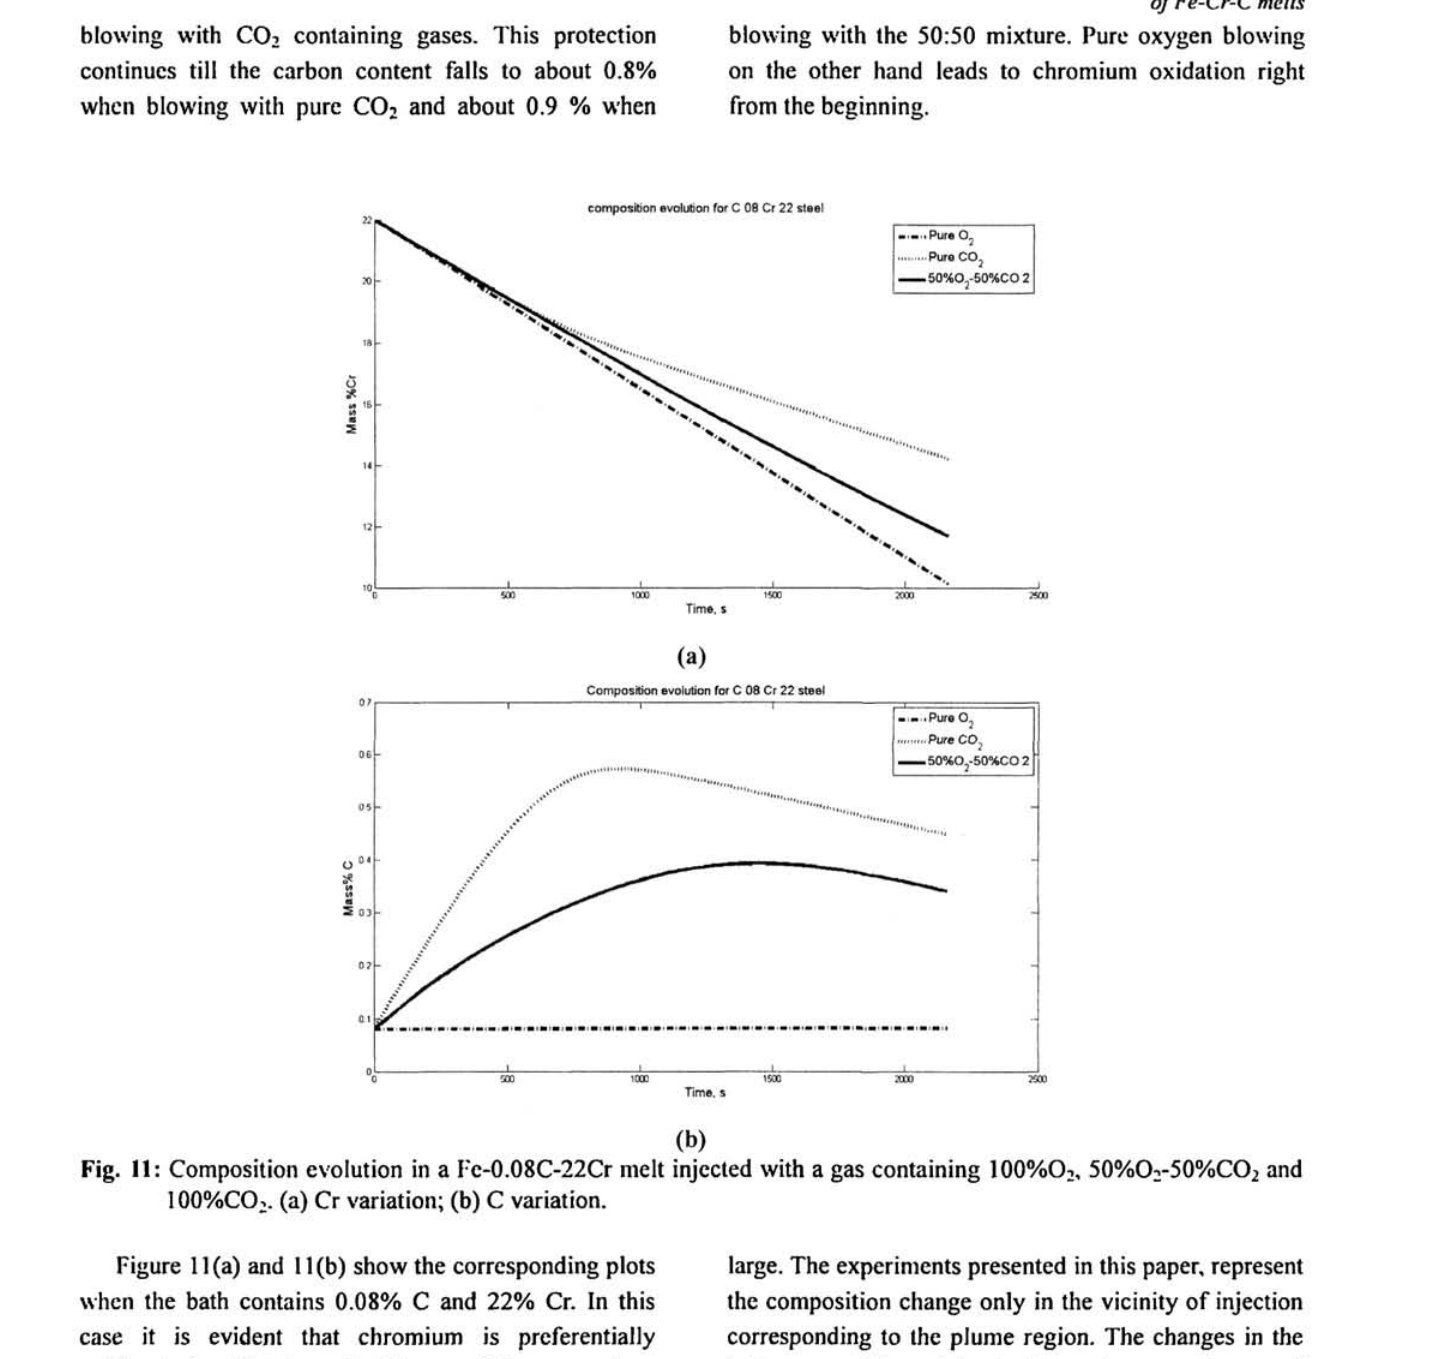
Fig. 11: Composition evolution in a Fe-0.08C-22Cr melt injected with a gas containing 100%O 100%CO . (a) Cr variation; (b) C ;